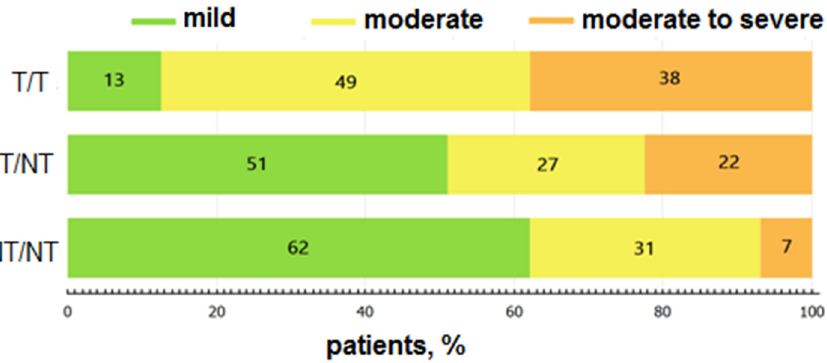
Figure 2. The distribution of patients according to the degree of hearing loss depends on genotypes: T/T, T/NT, NT/NT.